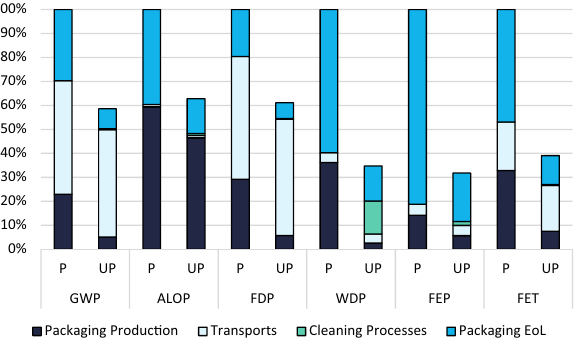
Fig. 3 Packed (P) vs. unpacked (UP) pasta. The results for the “packed” scenario are set to 100%, including the 4 phases packag- ing production, transports (excluding last mile), cleaning processes and packaging EoL only. The following impact categories were considered: climate change (GWP), agricultural land occupation (ALOP), fossil depletion (FDP), water depletion (FDP), freshwater eutrophication (FEP), freshwater ecotoxicity (FET)